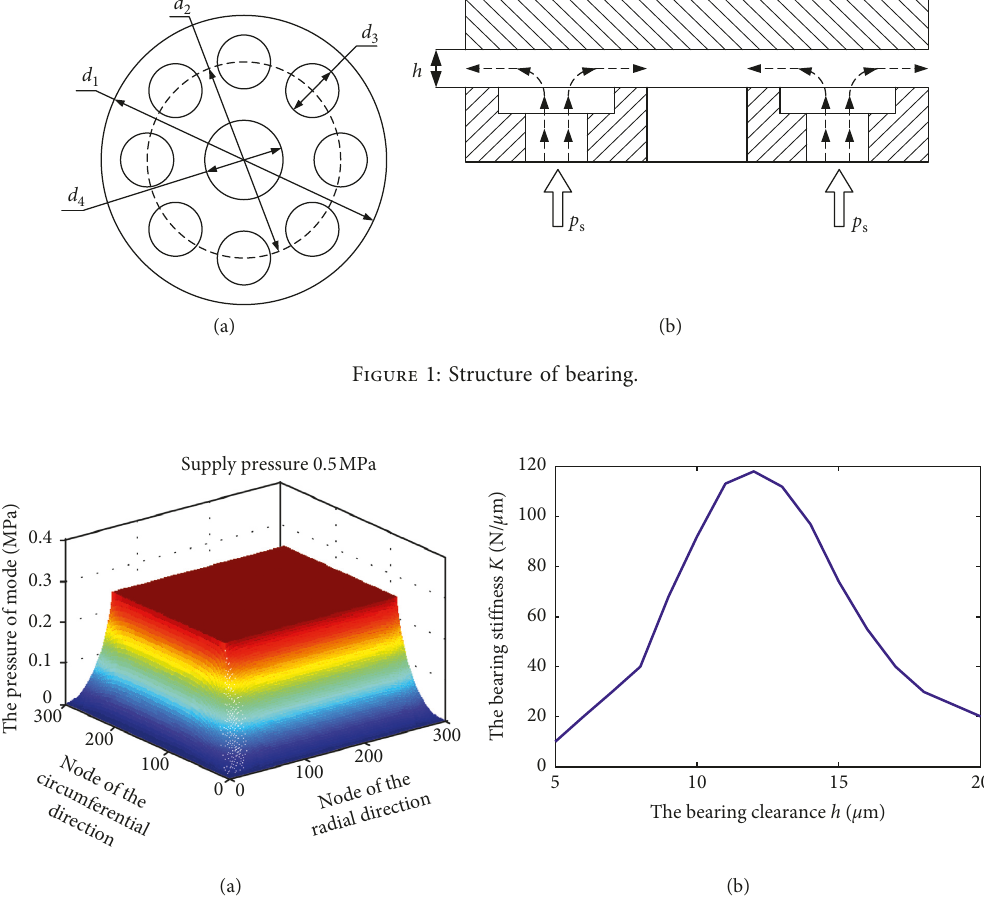
Figure 2: Performance of aerostatic spindle in axial direction. (a) Gas pressure distribution. (b) Relation between bearing stiffness and the gas film clearance.